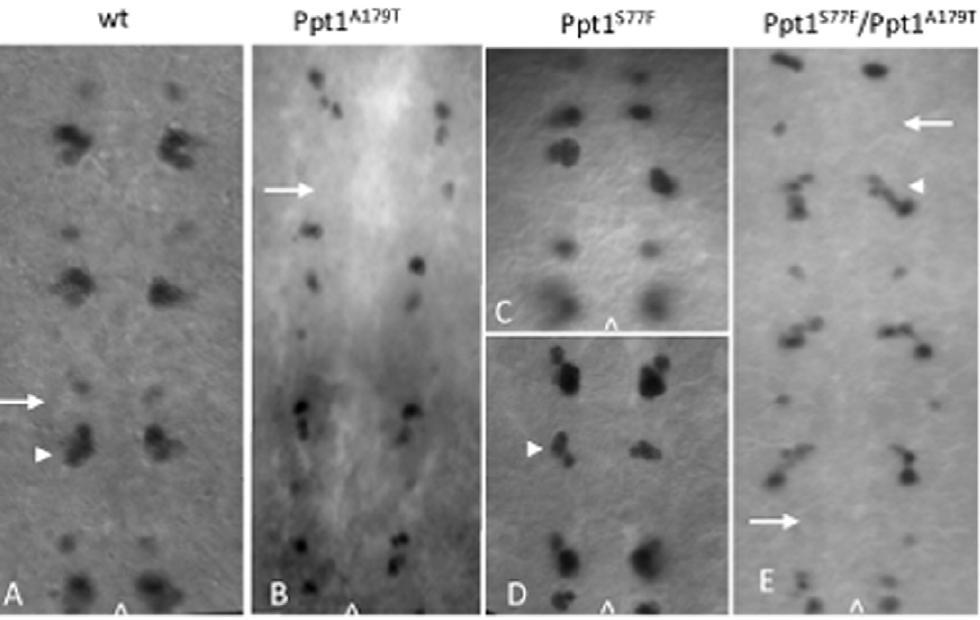
Figure 1. Ppt1 LOF mutants exhibit abnormal complement of EVE + neural precursors and neurons. (A) In wild type, EVE is expressed in GMC4-2.a, the neural precursor that give rise to RP2 motoneuron and its sib (arrow); and in a cluster of GMCs that give rise to the aCC, pCC, CQ neurons (arrowhead). (B–E) In Ppt1 mutants, many hemisegments exhibit a variety of phenotype including the loss of GMC4.2a (arrow in B and E), extra RP2/sib neurons (arrowhead in D), disorganized EVE + clusters (C), and extra aCC/pCC cells (arrowhead in E). In all panels, embryos are at S11–12 of development; anterior, up; caret, midline. doi:10.1371/journal.pone.0014402.g001 Ppt1 S77F 6 Df(1)446-20 trans-heterozygous crosses display a partial mutants and trans-heterozygous embryos show 12–17% loss in all hemisegments (Table 1). The degree of penetrance of this EVE loss of EVE + RP2 neurons (Figure 2; Table 2). In contrast, all Ppt1 neural phenotype is variable: all Df(1)446-20 embryos show at mutant strains outcrossed to wild type Oregon-R, Df(1)446-20/ + , Ppt1 A179T / + , and Ppt1 S77F / + , all showed normal EVE expression least two missing RP2s whereas Ppt1 A179T and Ppt1 S77F point mutations range from 32–50%. 63% of embryos from (Tables 1 and 2). These results indicate that the EVE phenotypes Ppt1 A179T 6 Df(1)446-20 trans-heterozygous crosses and 27% of are due to the loss of Ppt1.